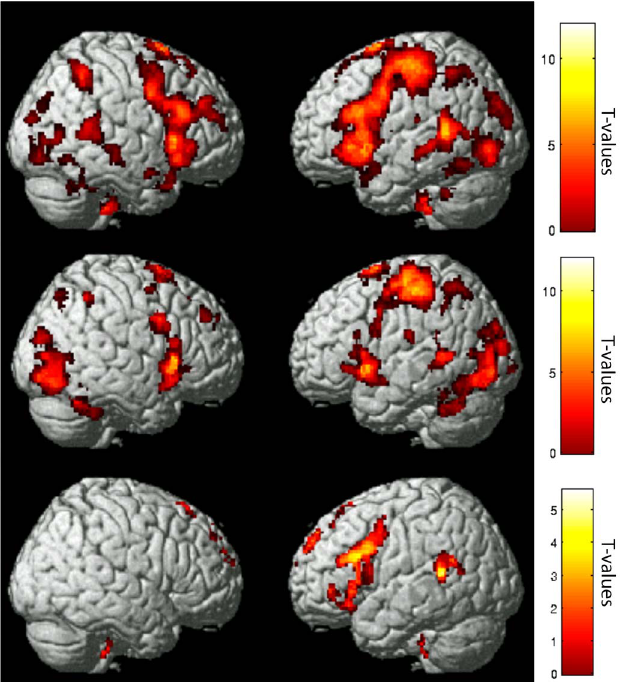
Figure 1. Sentence presentation rate differentially impacts brain activation by group. Fast . Medium . Slow parametric modulation (cluster level FDR corrected) for a) Typical Reader Group (p , .001) (top panel); b) Dyslexic Group (p , .001) (middle panel); c) Typical . Dyslexic Groups (p , .01) (bottom panel). Color bar indicates T-values.